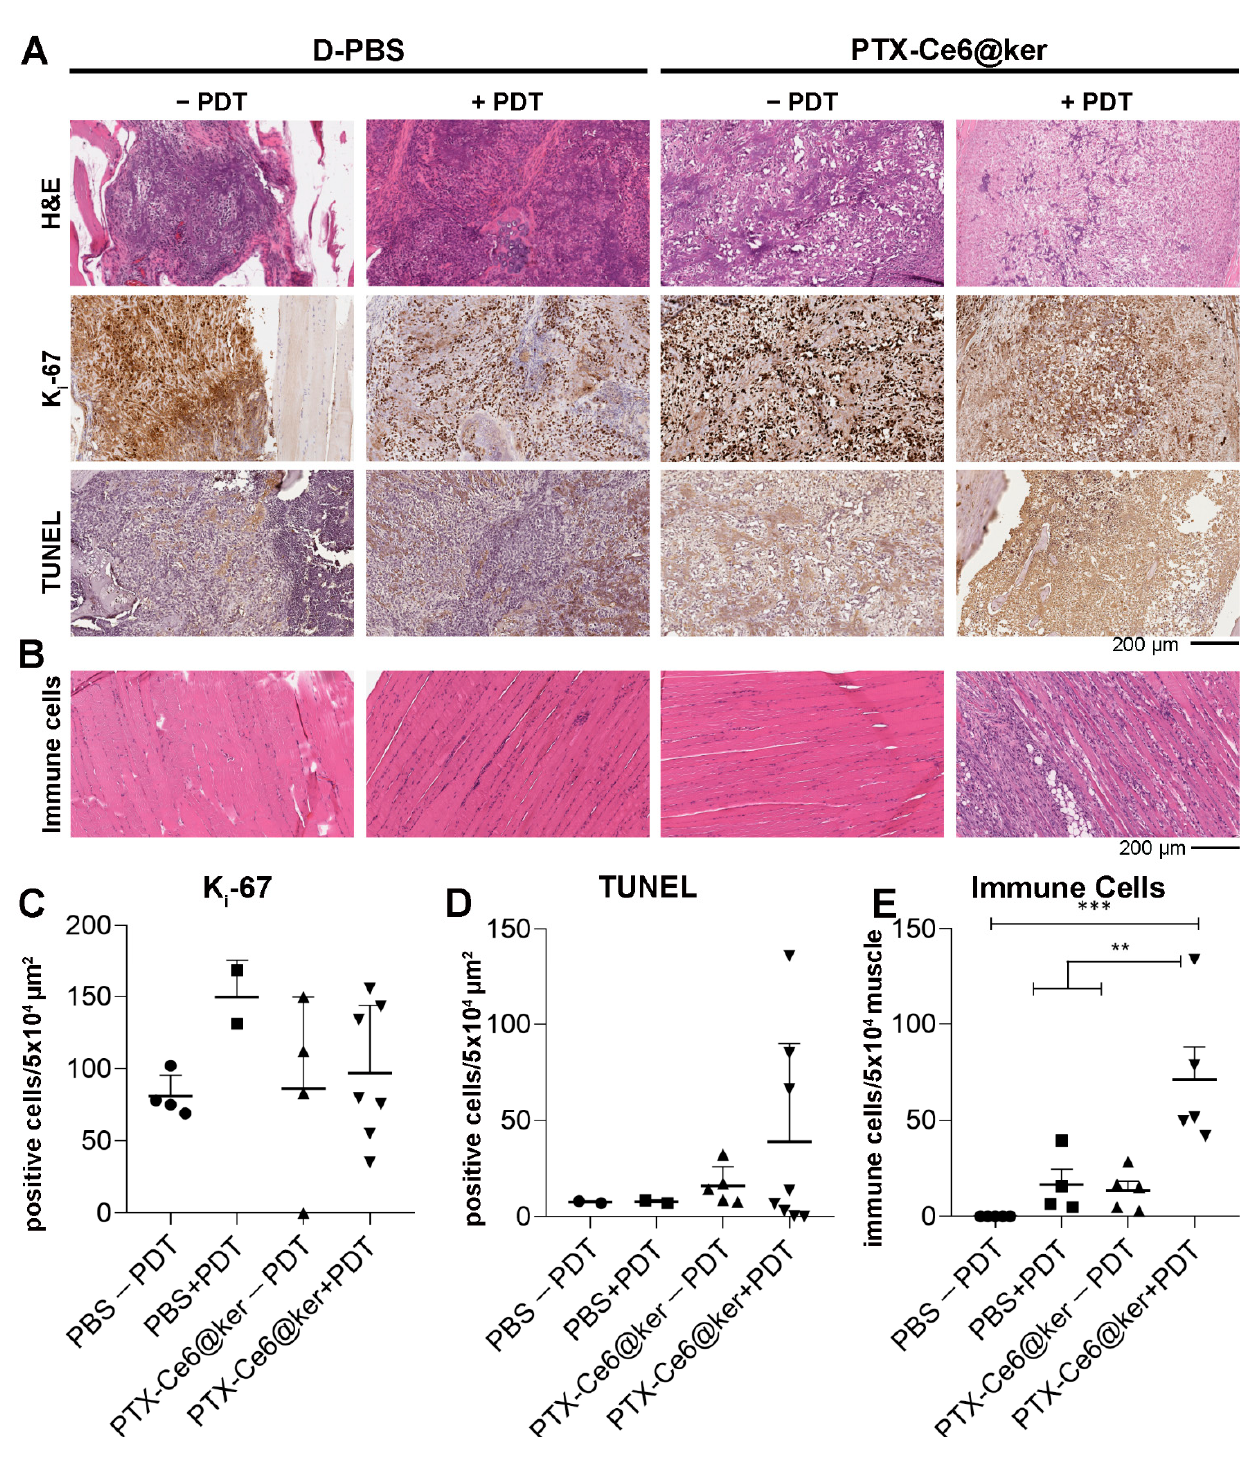
Figure 7. Preclinical evaluation of the therapy efficacy. ( A ) Representative paraffin sections from tibia explants of animals from control groups (D-PBS − /+ PDT) and treatment groups (PTX-Ce6@ker − /+ PDT) stained with the following markers: H&E, K i -67, and TUNEL. ( B ) Representative paraffin sections from muscle explants surrounding the tumor, stained with H&E. ( C , D ) The graphs show the quantification of K i -67 and TUNEL positive cells in four selected ROI/slices along the tumor tissue, respectively. ( E ) The graph shows the quantification of the immune cells in the muscle tissues after treatments. Data are expressed as the mean ± SD and analyzed using the one-way ANOVA test and Tukey’s multiple comparison test as a post-test. Results were statistically significant at p values < 0.05 (** p values < 0.01; *** p values <